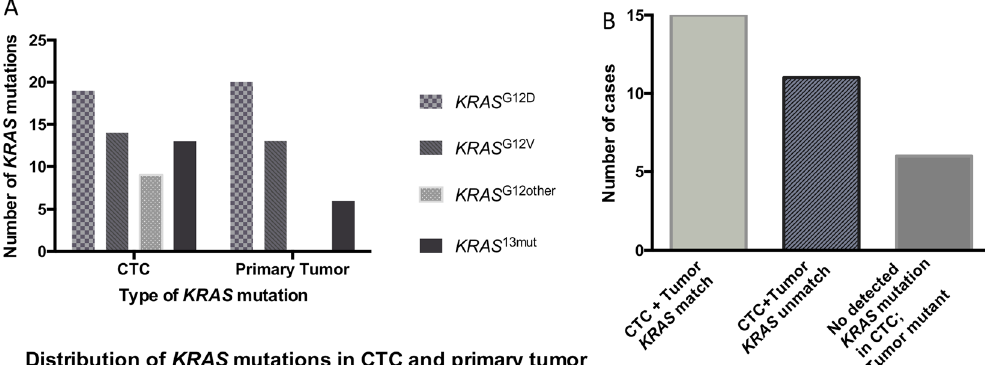
Figure 4. Distribution of KRAS mutations in CTC and the primary tumor. ( a ) KRAS mutations in CTC and the primary tumor: Several patients (n = 13) had multiple mutations in the CTC or primary tumor, in 20 cases no tissue was available. ( b ) Substantial discordance of KRAS mutations in CTC and the primary tumor (n = 9): those with no available tissue samples were excluded (n = 20); 5 were CTC negative. Cyto pos = cytology positive; MS = median survival (in